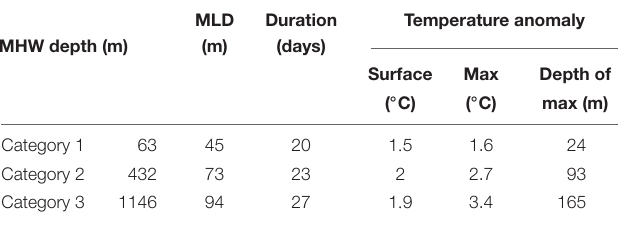
TABLE 1 | Mean characteristics of MHWs in categories 1 (0–150 m), 2 (150–800 m), and 3 (800–2000 m) from Argo data: depth extent, mixed layer depth, duration, sea-surface temperature anomaly (Surface, from SST and Argo floats), maximum temperature anomaly (Max) and the depth where it occurs (Depth of